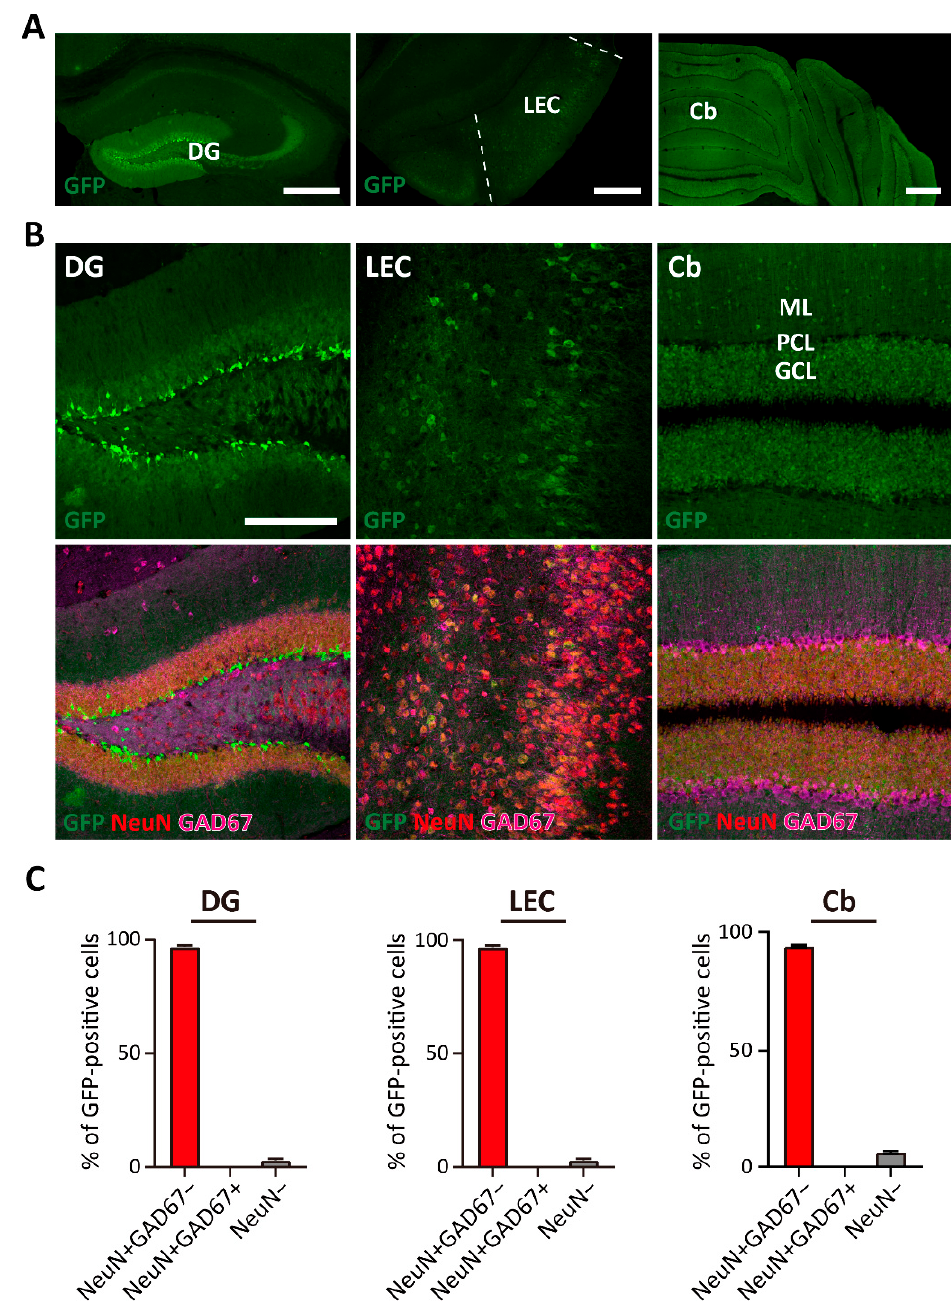
Figure 2. Cellular identification of GFP-expressing cells of the DG, LEC, and Cb in P56 of TWIK-1 BAC-GFP Tg mice. ( A ) Overview of GFP expression in DG, LEC, and CB of TWIK-1 BAC-GFP Tg mice. Scale bar, 200 μ m. ( B ) Representative co-immunofluorescence images with GFP, NeuN, and GAD67 antibodies. Scale bar, 200 μ m. ( C ) Quantification bar graph of the cell type of GFP-positive cells in each brain area from B. Quantification was analyzed by the percentage of each cell type from all GFP-positive cells. Raw data are listed in supplementary Table 1. Data are presented as the Mean ± SEM.